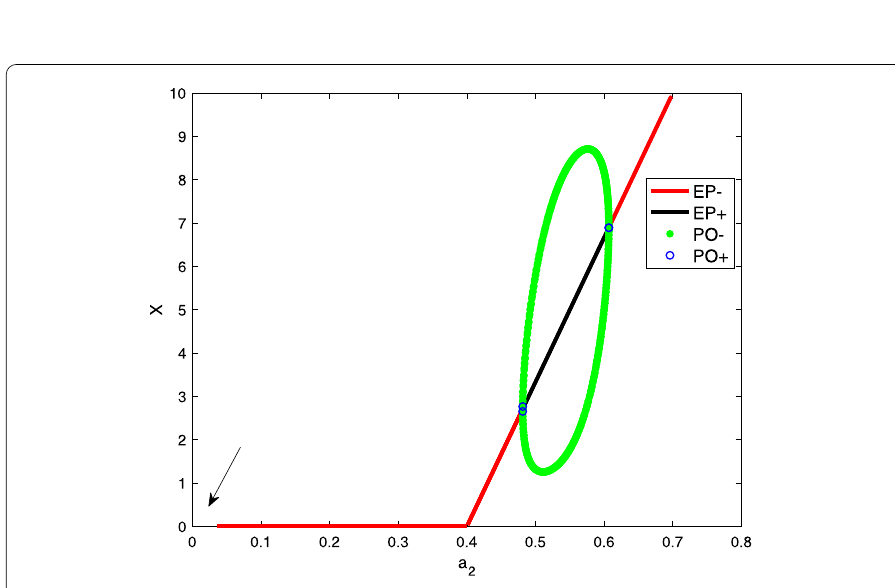
Figure 2 A bifurcation diagram showing X as a function of a 2 . Parameter values are a 1 = 0.3, a 2 = 0.6, a 3 = 4, a 4 = 10, and (cid:5) = 0.05